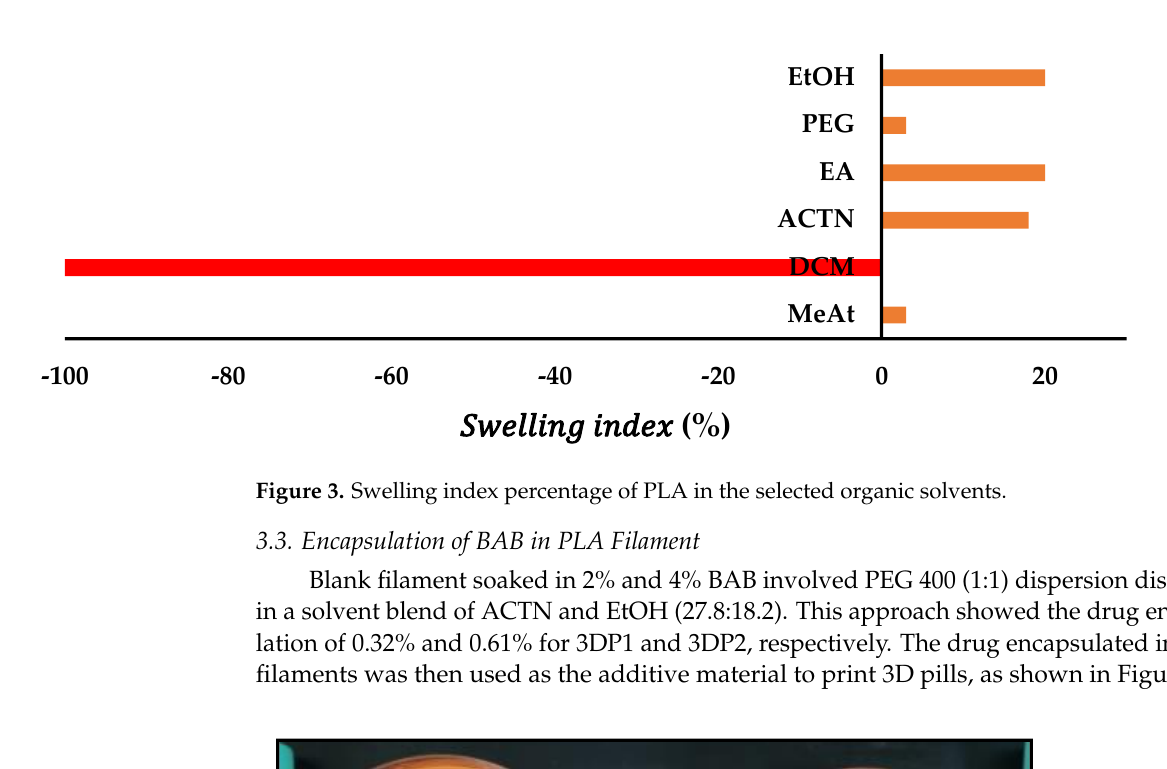
Figure 4. Encapsulation of BAB in the PLA unprocessed filament (3DP1 and 3DP2).